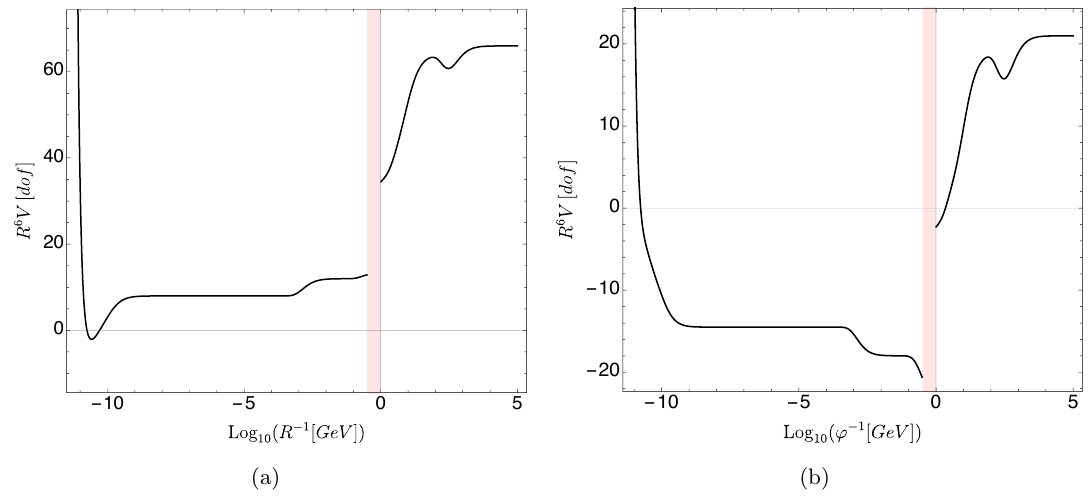
Figure 4 . (a) E(cid:11)ective potential of the Standard Model compacti(cid:12)ed in a circle with periodic boundary conditions for all particles, the Higgs (cid:12)xed at its minimum and all Wilson lines turned o(cid:11). There is no runaway solution. The only AdS minimum we have is the one that would be associated with neutrino bounds. (b) E(cid:11)ective potential of the Standard Model with periodic boundary conditions for all particles except for the leptons. The Higgs is (cid:12)xed at its minimum and all Wilson lines are turned o(cid:11). There is no runaway solution. We (cid:12)nd an AdS minimum